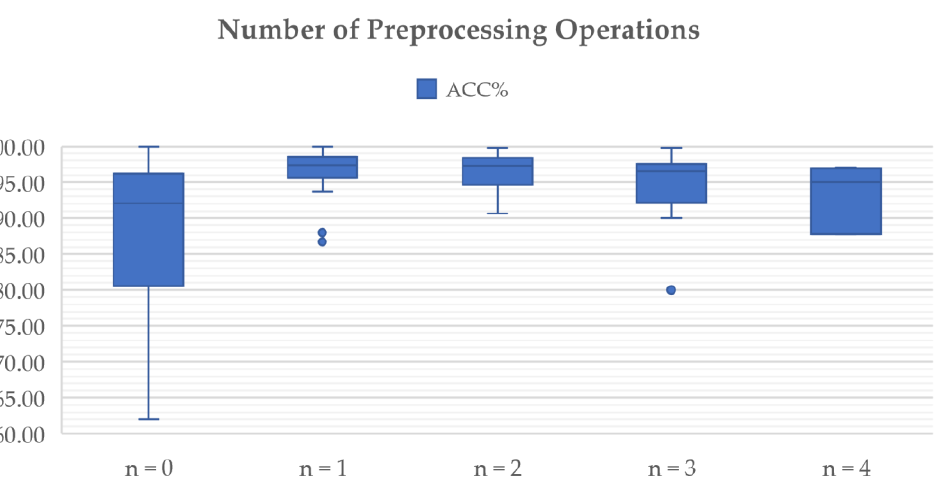
Figure 12. Classification accuracy by number of preprocessing operations.